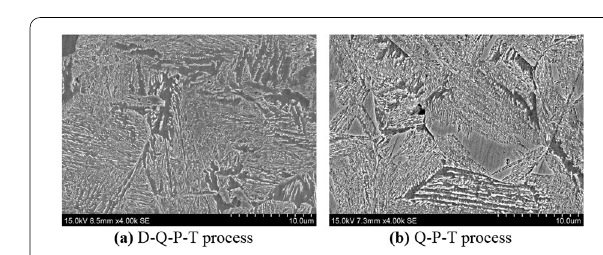
Figure 9 SEM micrographs of the D-Q-P-T and Q-P-T samples